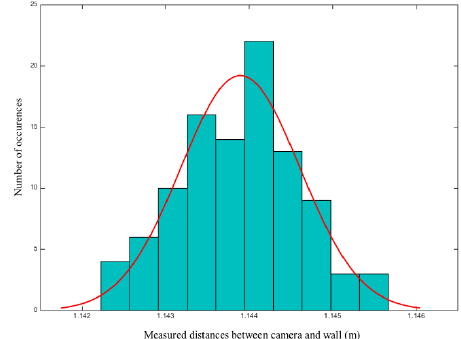
Figure 4. Histogram of 100 distance measurements performed for a 3 x 3 pixels central